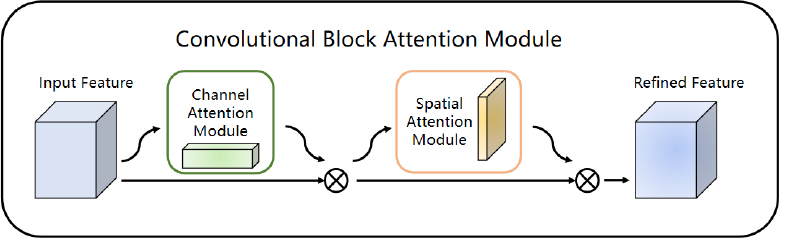
Figure 6. CBAM structure . Figure 6. CBAM